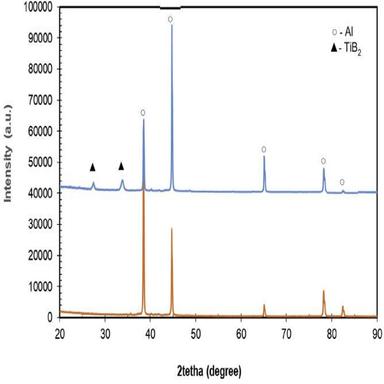
XRD patterns from (a) AA6061 aluminum alloy before FSP treatment and (b) for processed AA6061-1 wt% Graphene-20 wt% TiB2 hybrid nanocomposite.